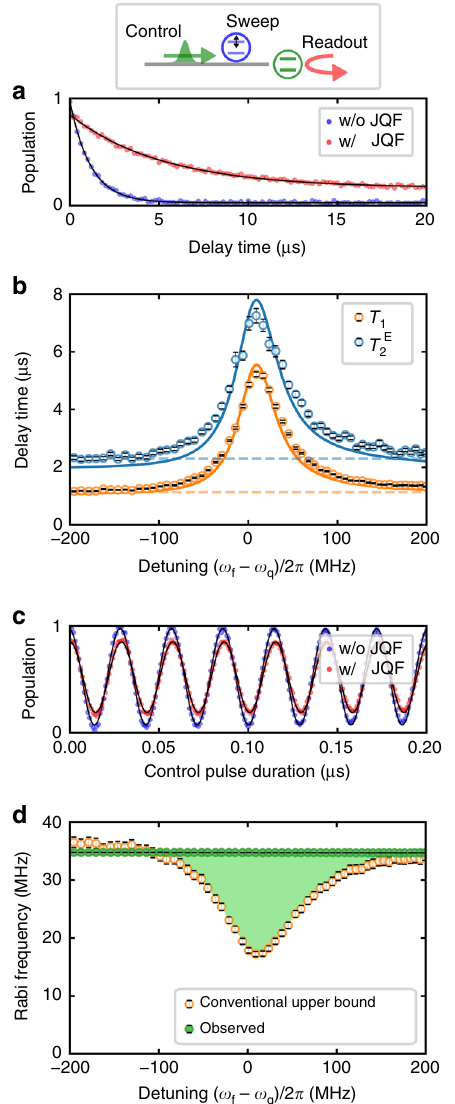
Fig. 3 Breaking the trade-off between the fast control and long lifetime of the qubit with the JQF. The red and blue dots are the experimental results with and without the JQF, respectively. The black lines are the theoretical fi ts. a Qubit population in the excited state as a function of the delay time between the π pulse and the readout. b Decay times as a function of the JQF – qubit detuning. The orange and cyan circles depict the relaxation time ( T 1 ) and the Hahn-echo coherence time ( T E ), respectively. The solid lines 2 are the numerically simulated results (see more details in Supplementary Notes 3 and 4). The horizontal dashed lines are those in the absence of the JQF. c Qubit population in the excited state as a function of the duration of a square control pulse with Gaussian edges. d Rabi frequency as a function of the JQF – qubit detuning. The green circles are the observed Rabi frequency in the presence of the JQF, and the orange circles are the conventional upper bound of the Rabi frequency for the given drive power, ffiffiffiffiffiffiffiffiffi p _ n = T which is calculated as 2 . The error bars represent standard 1